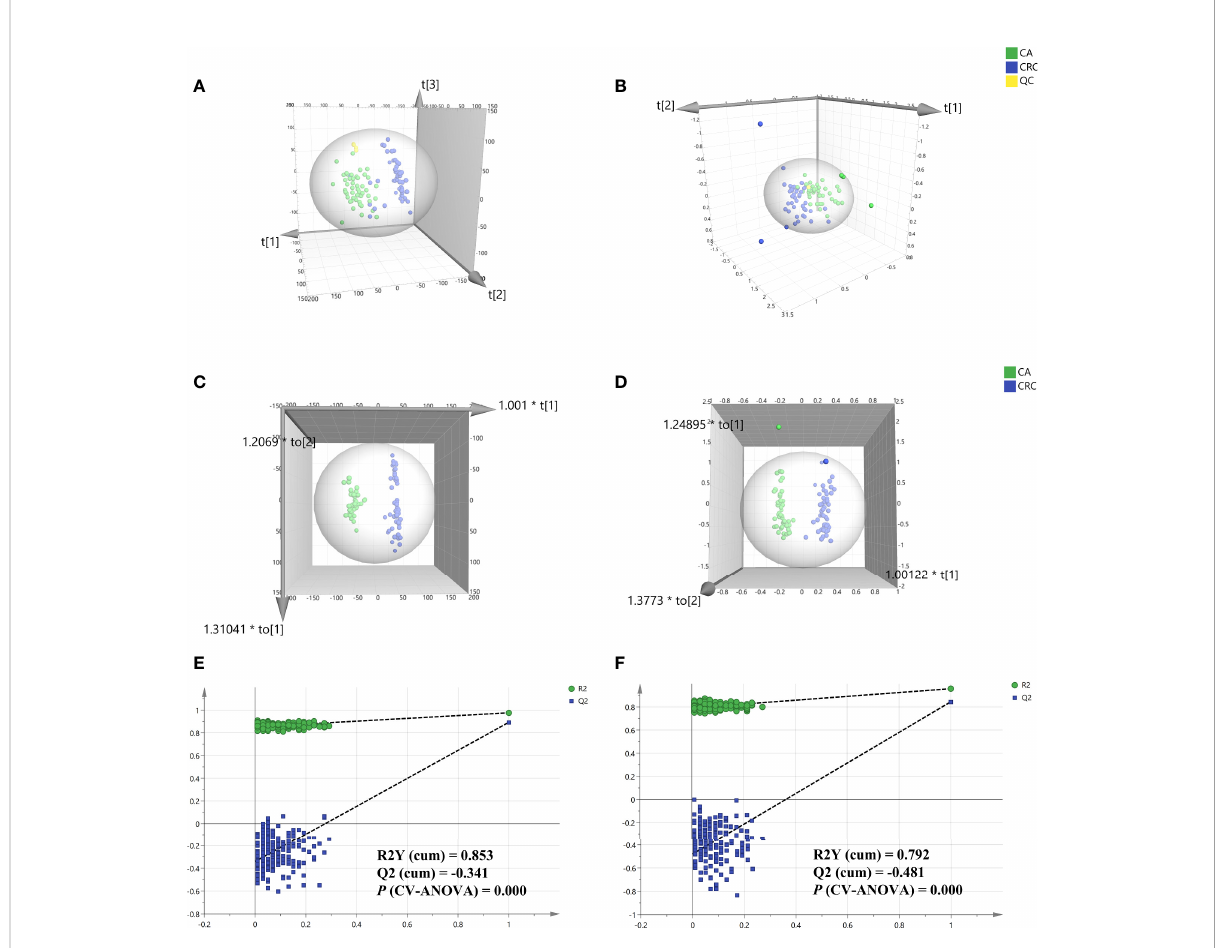
FIGURE 2 Multivariate statistical analysis of differential lipid features between CA and CRC groups in both ESI modes. PCA analysis of two groups in ESI+ and ESI- modes, respectively (A, B) ; OPLS-DA analysis of the two groups in ESI+ and ESI − modes, respectively (C, D) ; Over fi tting test for OPLS- DA model in ESI+ and ESI − modes, respectively (E, F)